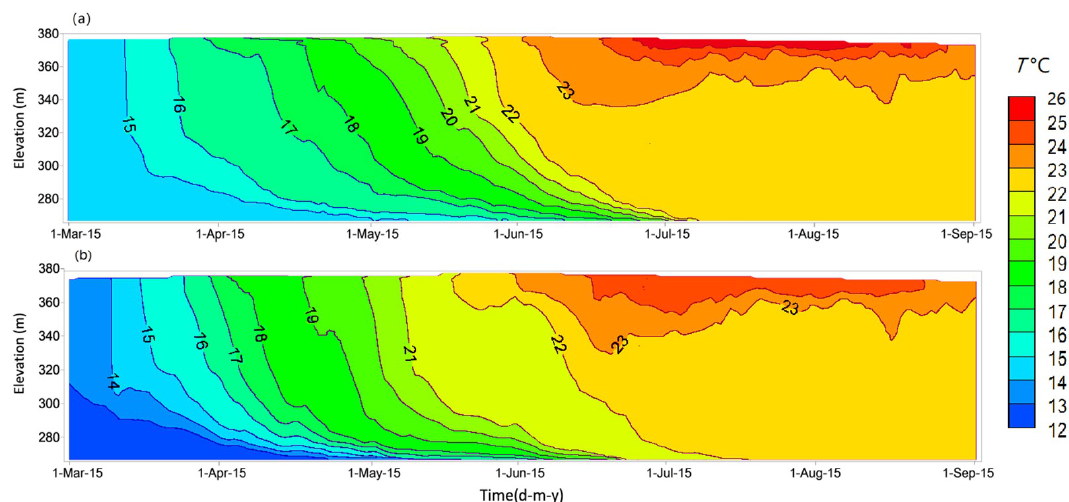
Figure 7. Contour plots of simulated water temperatures at a cross-section near the Xiangjiaba dam from March to August 2015, with the Xiluodu reservoir ( a ) and without Xiluodu operation ( b ).